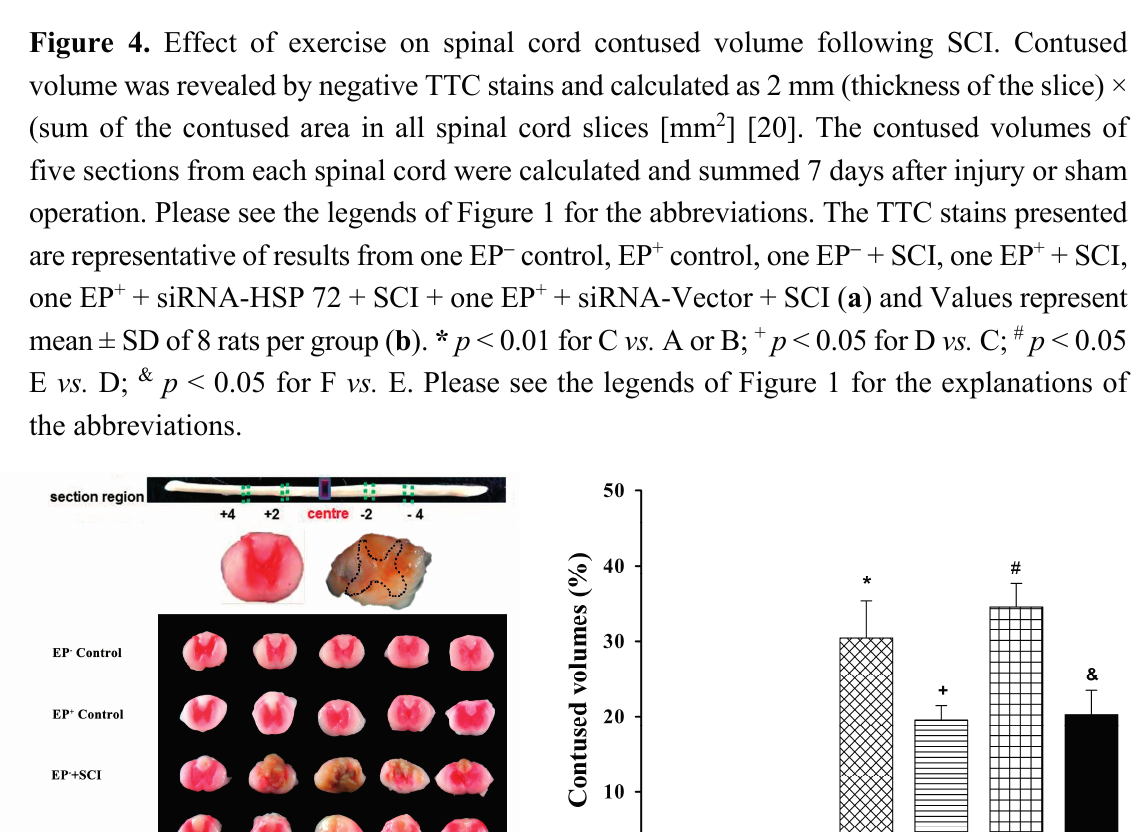
2.5. Post-Laminectomy Gray Matter Neuronal Loss Was Significantly Lower in the EP + Group Immunohistochemical staining 7 days post-laminectomy showed that EP + Control group rats had significantly ( p < 0.01) more NeuN + cells than did the EP − Control group rats and that EP + + SCI group rats had significantly ( p < 0.01) more NeuN + cells than did EP − Control group rats and EP + Control group rats (Figure 6). Rats in EP + + siRNA- HSP 72 + SCI group had significantly less NeuN + cells than did the EP + + siRNA-vector + SCI group or the EP + + SCI group (Figure